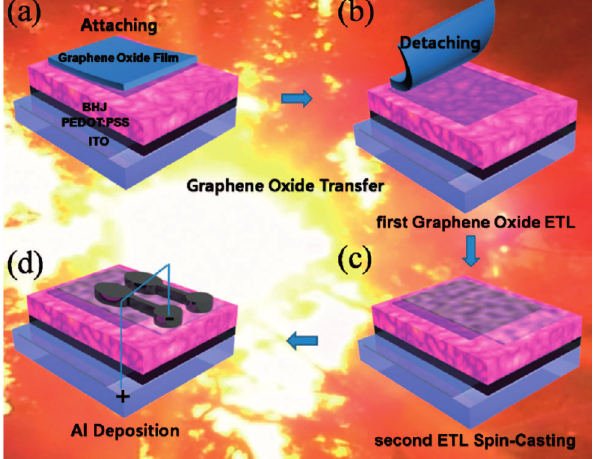
Figure 16. Schematic illustration and fabrication steps of BHJ polymer solar cells with a graphene oxide (GO) cathode IFL applied by stamping transfer. ( a ) Attachment of the transfer film on top of the BHJ active layer; ( b ) after detachment of the film, the first GO cathode IFL is uniformly transferred and coated onto the BHJ layer; ( c ) spin-casting of second cathode IFL of TiO x on top of GO; ( d ) completed device structure after Al deposition. Reprinted with permission from [101]. Copyright 2013 Wiley-VCH Verlag GmbH & Co.